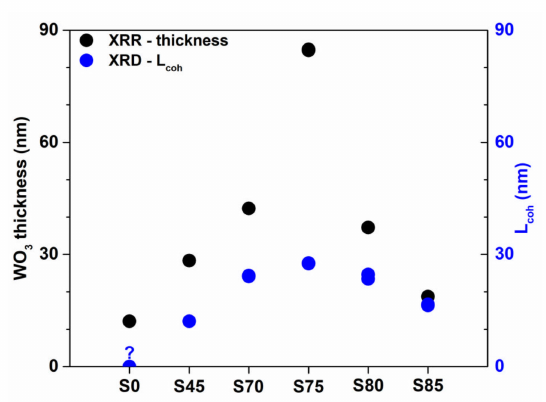
Figure 4. Thicknesses (black dots) and coherence length (blue dots) of WO 3 thin films.